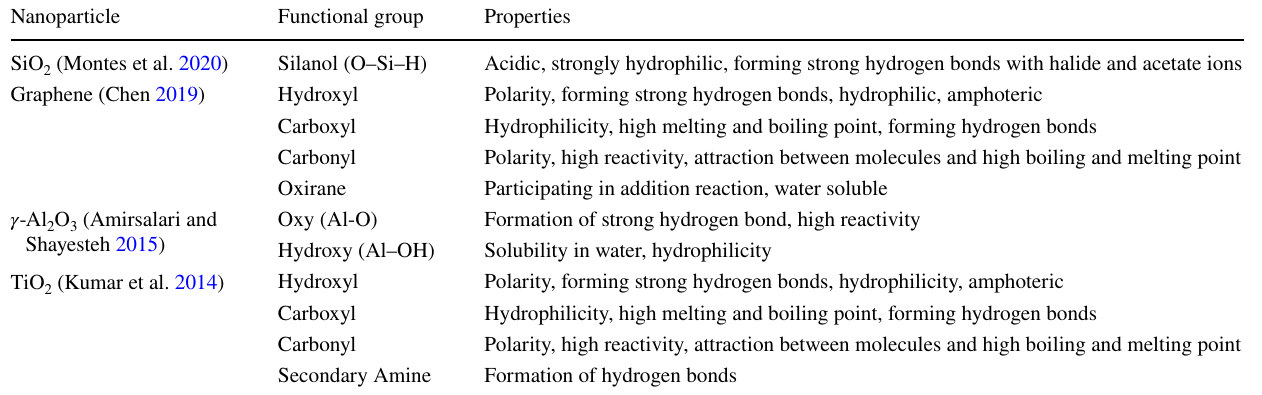
Table 2 Functional groups and properties of some commonly used NPs for EOR